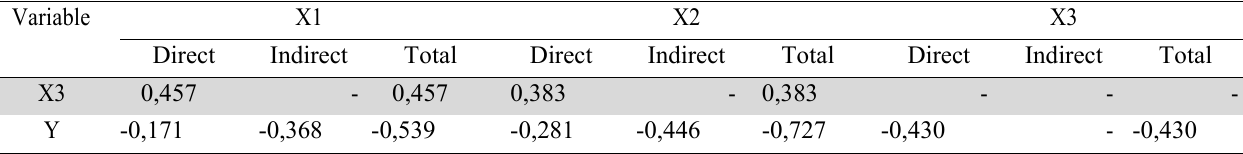
Coefficients of Direct, Indirect, and Total